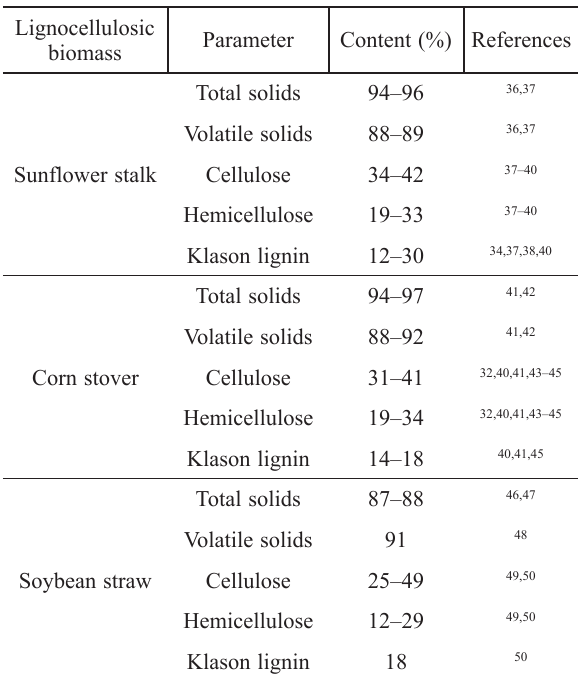
Table 3 – Chemical composition of lignocellulosic biomass Lignocellulosic biomass